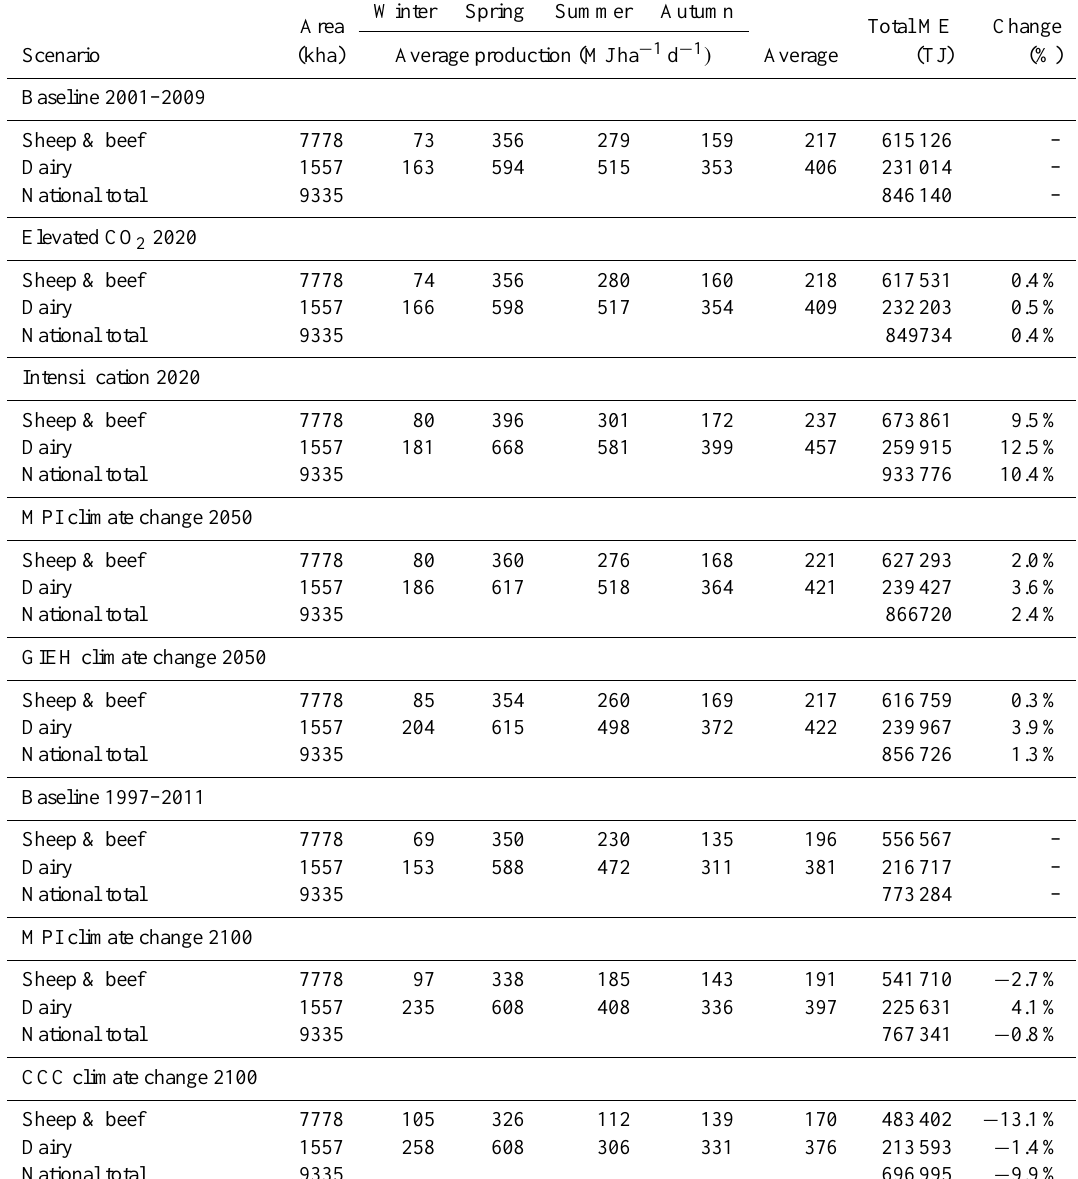
Table 3. Summary of model scenario results with constant land-use area, tabulated by scenario and season. Percent change calculated in reference to the baseline scenario. Seasonal numbers are averages over the modelled time slice, and national totals are the annual average sum of sheep/beef and dairy results. ME is metabolisable energy, defined as the amount of energy available to grazing